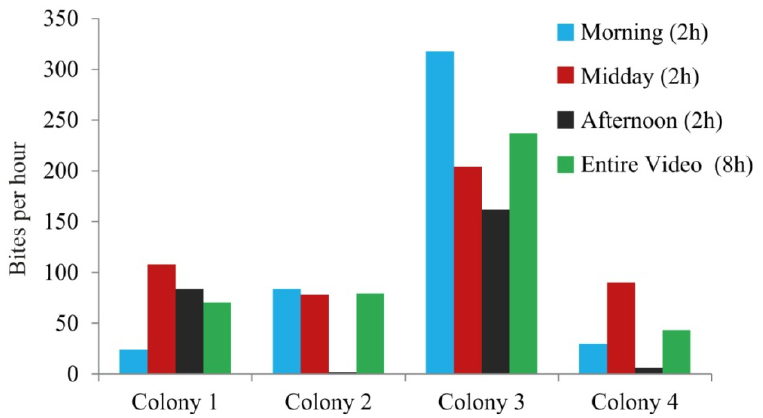
Figure 5. Different bite rates of butterflyfishes on four coral colonies calculated from the same video recording using either short-term intervals of two hours (morning, midday and afternoon) or the entire video sequence of eight